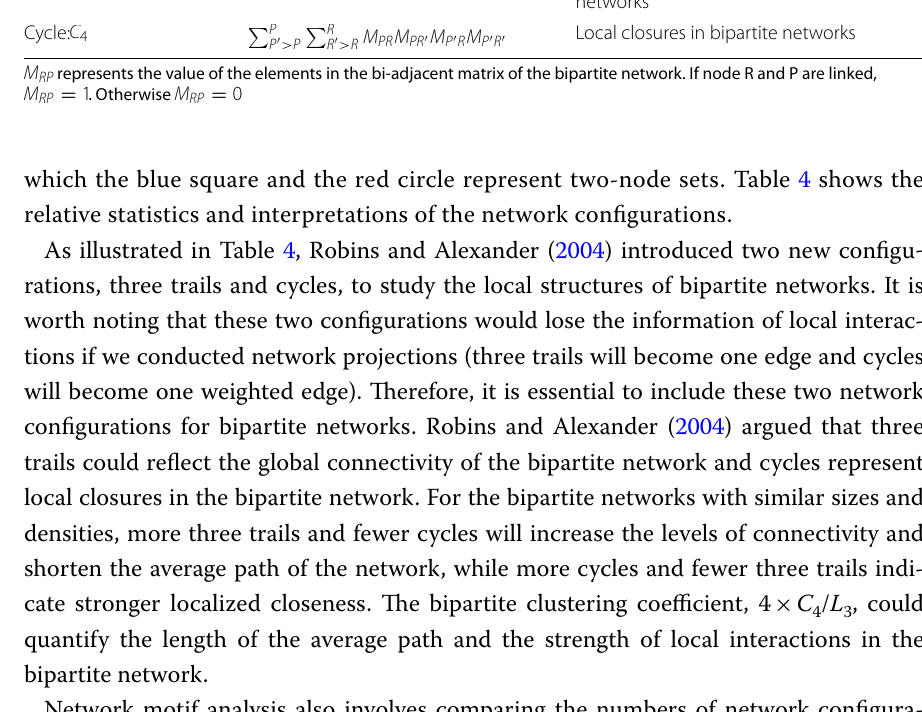
M RP represents the value of the elements in the bi-adjacent matrix of the bipartite network. If node R and P are linked, M RP = 1 . Otherwise M RP = 0